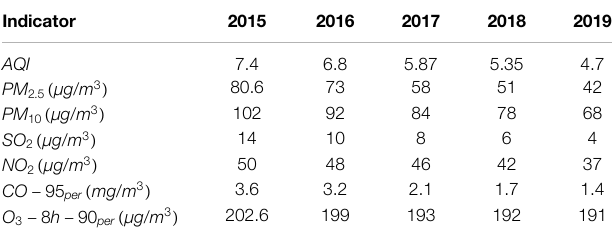
TABLE 1 | Air pollution data of